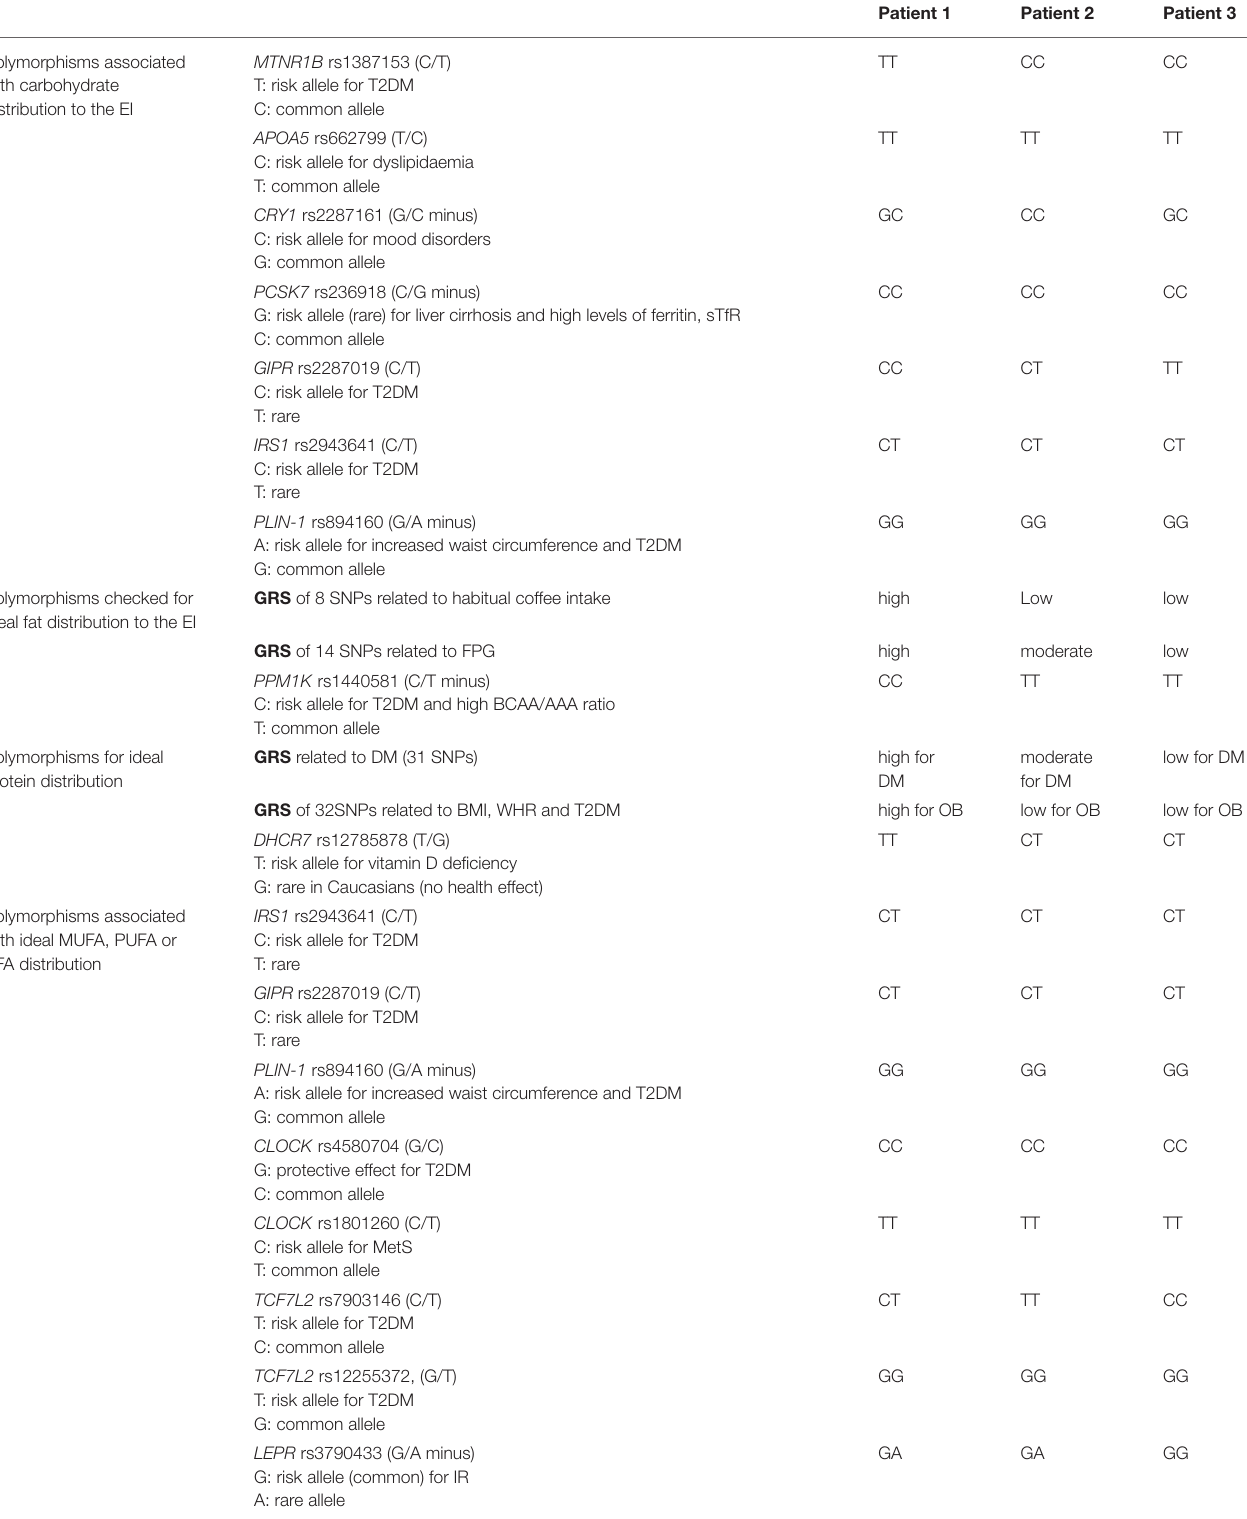
Patient 1 Patient 2 Patient